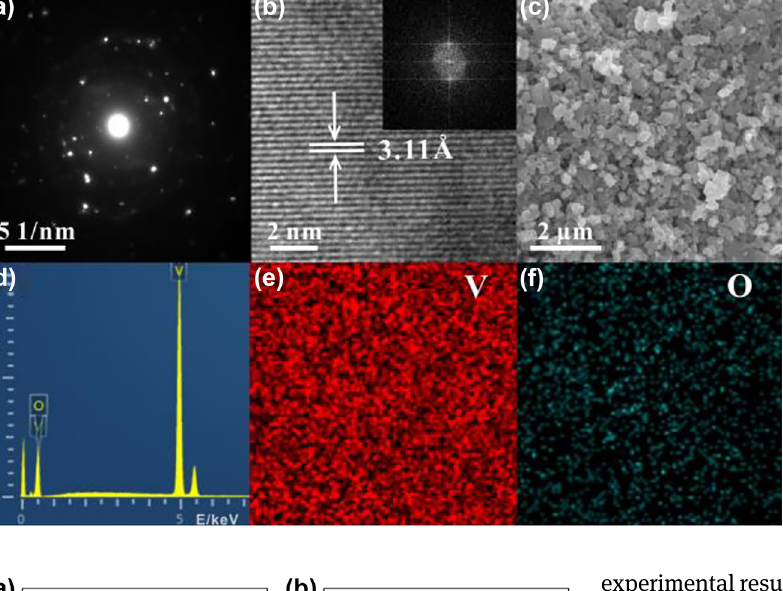
Figure 1: Material characterization. (a) SAED image. (b) TEM image. The inset is the FFT image. (c) SEM image. (d) EDS diagram.(e)and(f)EDSmappingsofVandO.